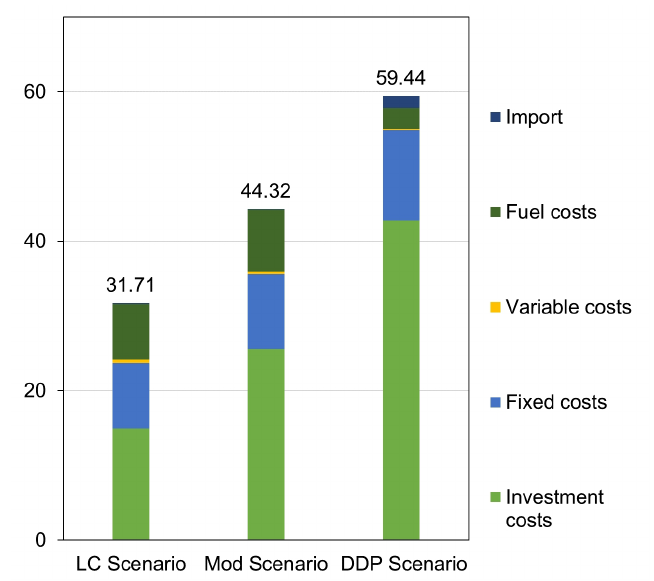
Figure 12. Costs of the system in USD billion for the LC, Mod, and DDP